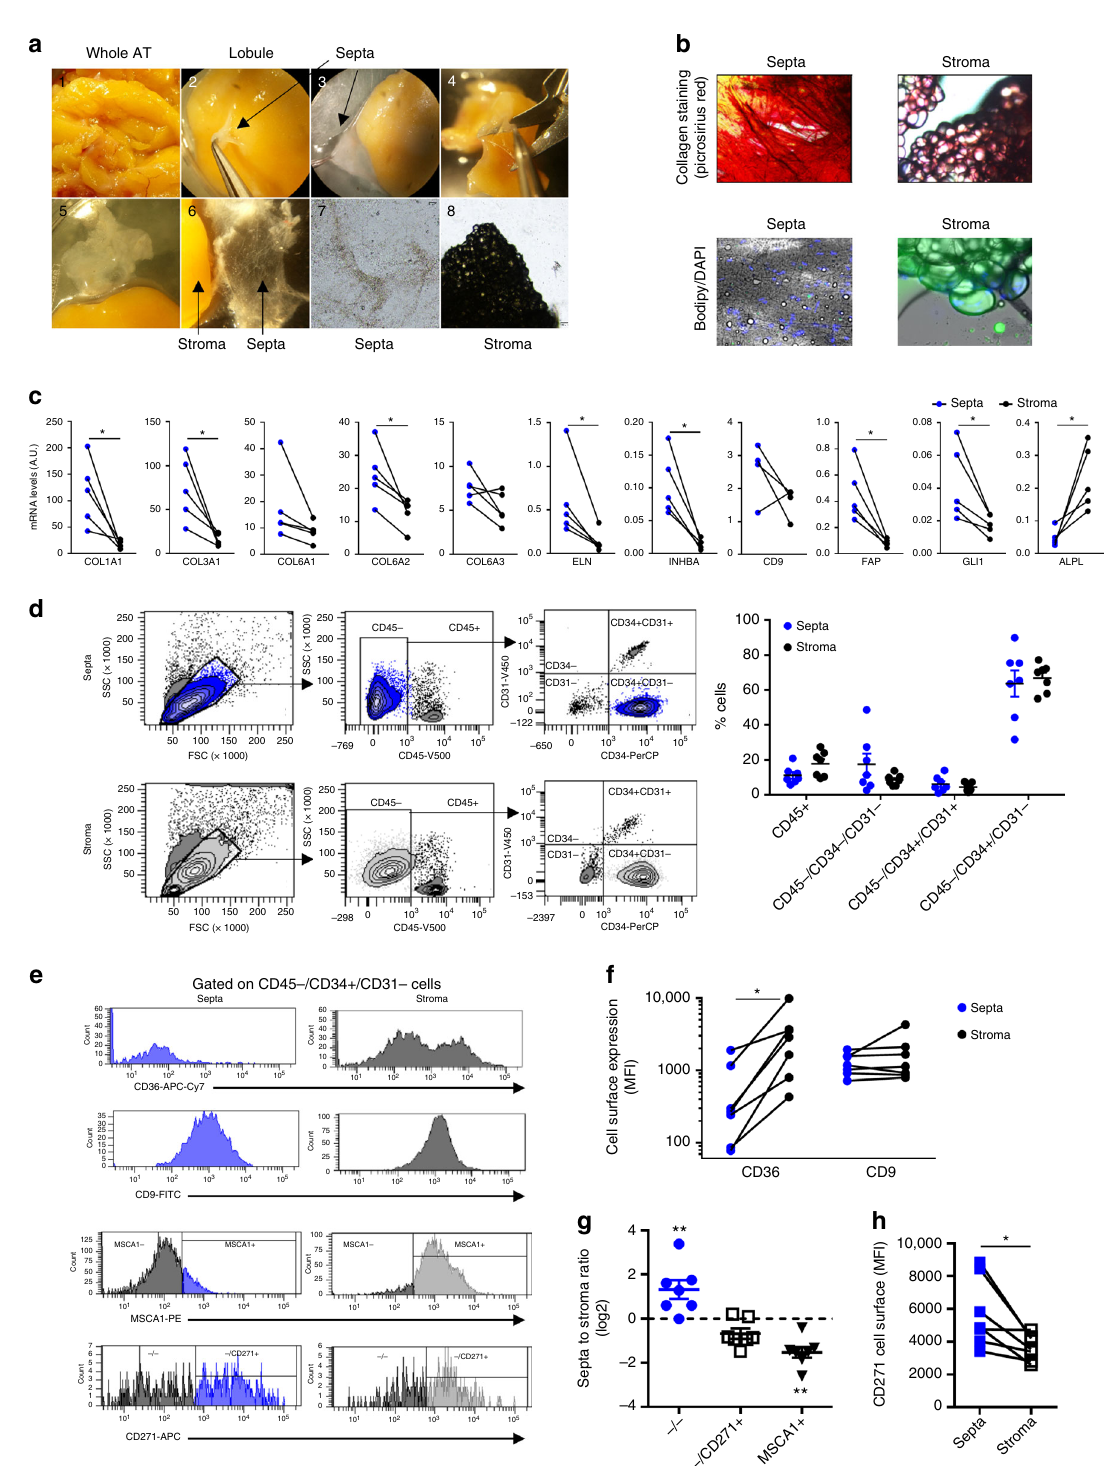
Fig. 1 Macro- and micro-architecture of human adipose tissue lobule. a Representative three-dimensional image of the collagen network (picrosirius red) of human adipose tissue (AT) lobules with surface reconstruction of the longitudinal and transversal views, fi brous septa, and stroma are underlined, scale bars: 100 µ m. b Representative immunostaining of the human AT lobule with COLLAGEN 1 (COL1), CD34, and DAPI. The position of the septa is underlined, scale bar: 100 µ m. c Representative immunostaining of the human AT lobule septa with collagen 3 (COL3) and ELASTIN (ELN), white scale bars: 50 µ m. d Electronic microcopy analyses performed on human subcutaneous adipose lobule septa and stroma (F: extracellular matrix fi bers, Ad: mature adipocytes), black scale bars: 1 µ m. e Representative immunostaining with CD34 and DAPI of the subcutaneous lobule septa and stroma, white scale bars: 100 µ m. f Electronic microcopy analyses performed on the human subcutaneous adipose lobule septa (upper panel) and stroma (lower panel) (Ad: mature adipocytes, F: extracellular matrix fi